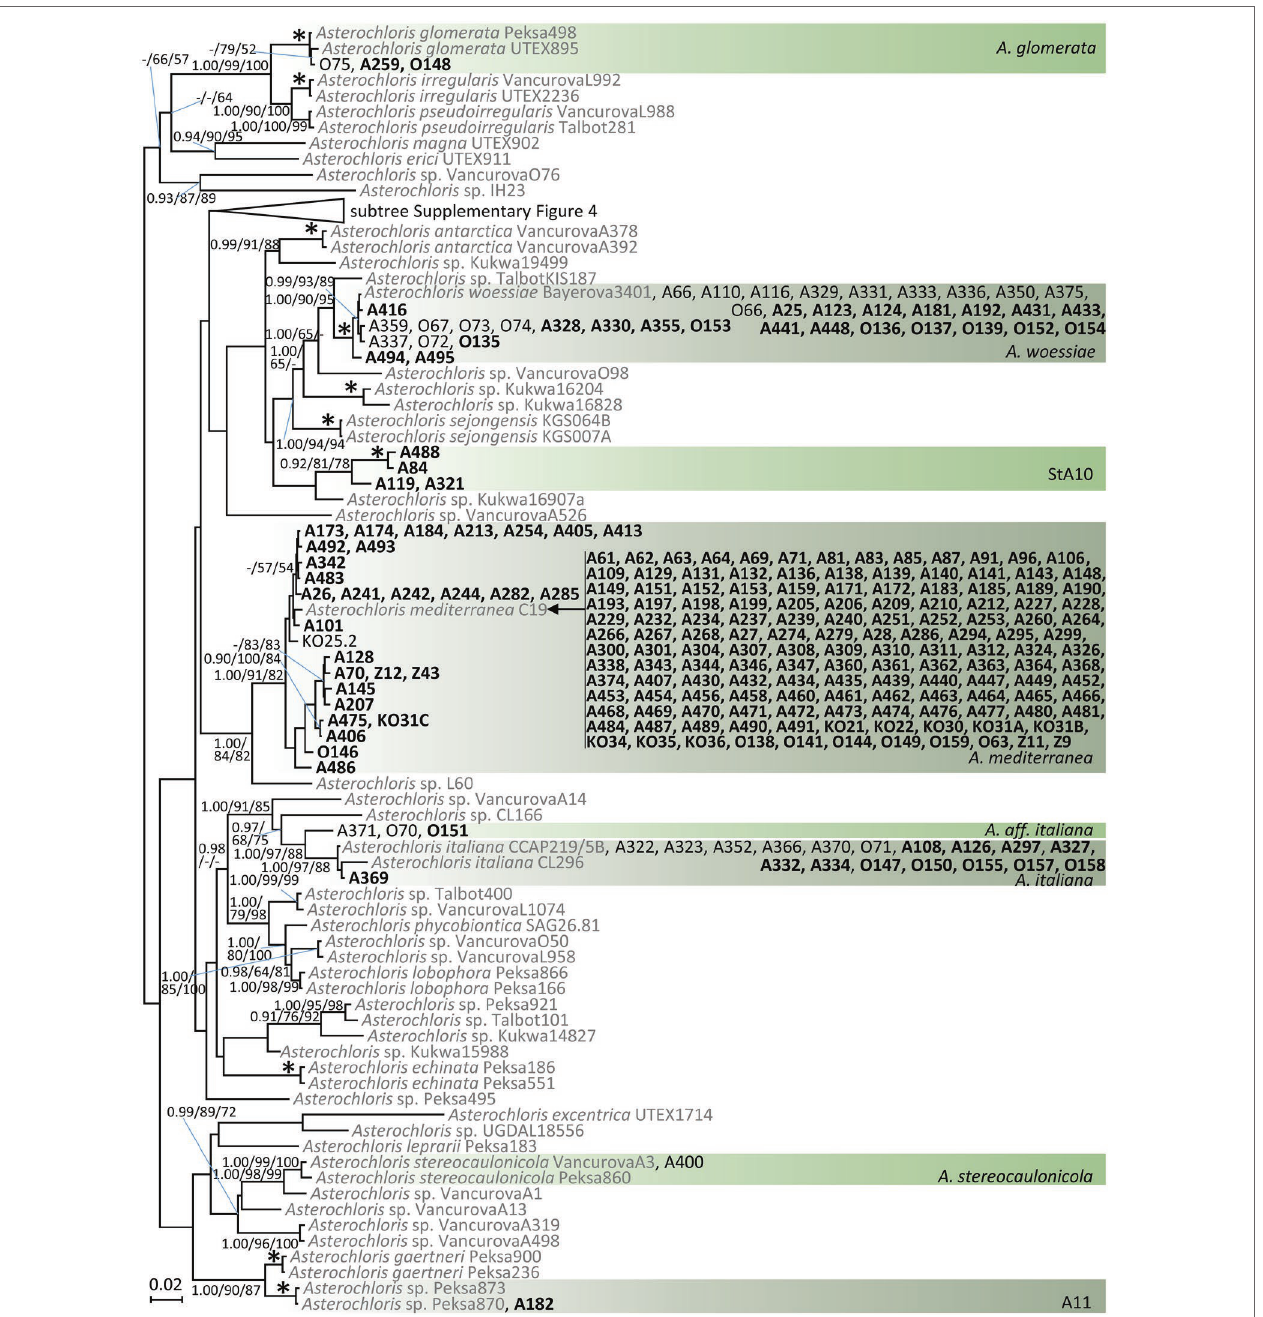
FIGURE 2 | Phylogenetic hypothesis (unrooted tree) of Asterochloris resulting from Bayesian analysis of ITS rDNA. Values at the nodes indicate the statistical supports of Bayesian posterior probability (left), maximum-likelihood bootstrap (middle) and maximum parsimony bootstrap (right). Scale bar shows the estimated number of substitutions per site. Newly obtained sequences are marked in bold. We selected the reference sequences from GenBank (in grey; accession numbers are listed in Supplementary Table 4 ) taking care to include all known Asterochloris species as well as other previously published Asterochloris species-level lineages. The collapsed clade is displayed in Supplementary Figure 4